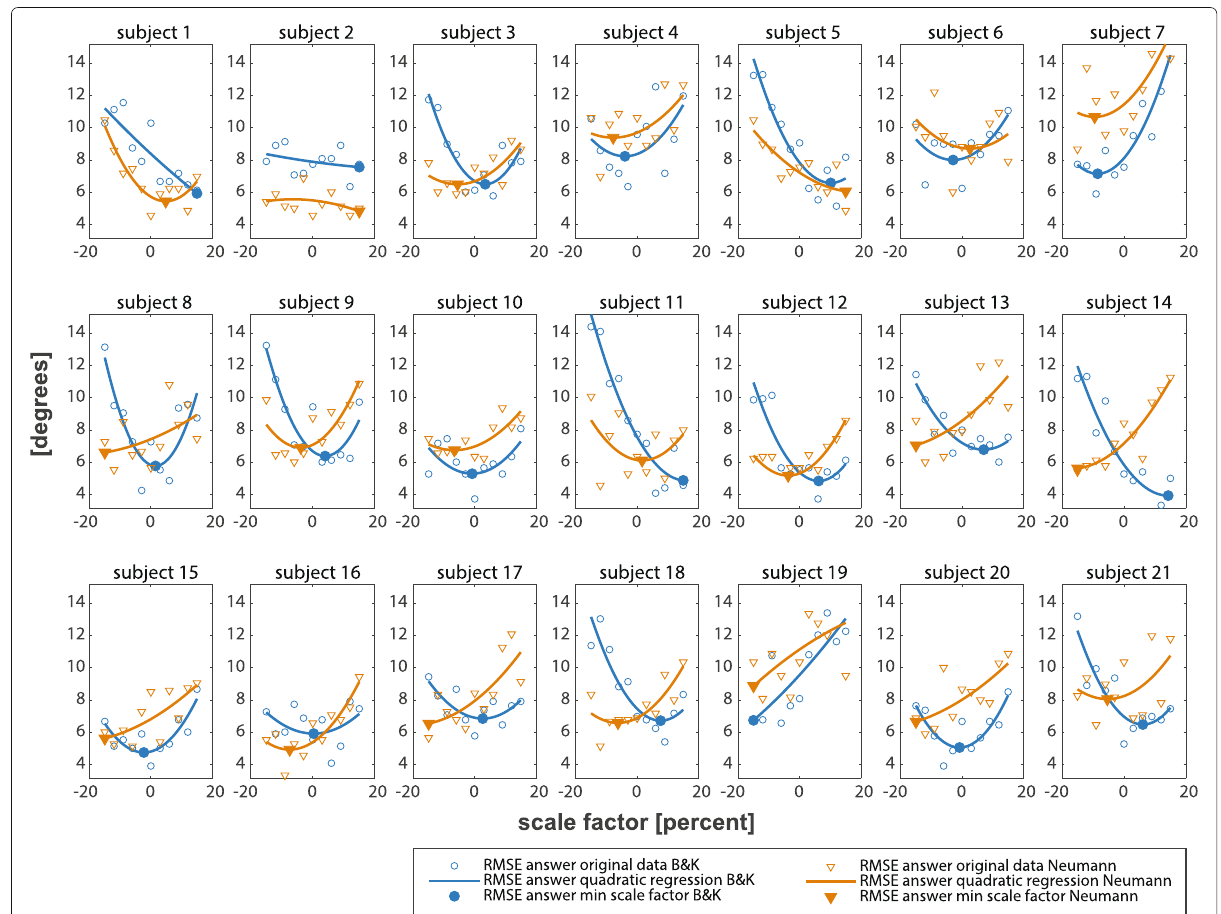
Fig. 8 Minimum error scaling factors for the ITD of the two dummy heads (Brüel & Kjær 4100 and Neumann KU100) of all the subjects who performed the exploratory perceptual test. These ITD scaling factors were used for the calculation of the polynomial equation coefficients of the subjectivecriterion